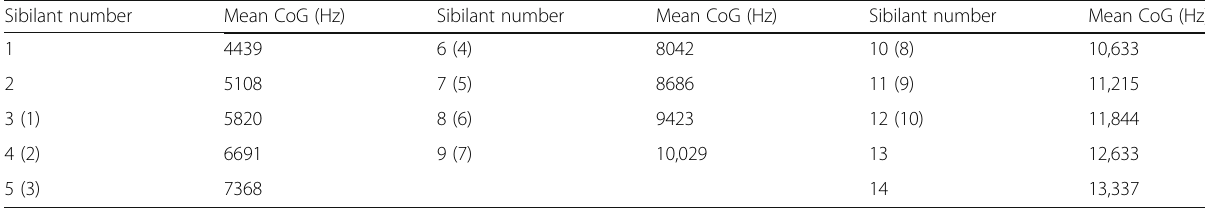
Table 1 Mean center-of-gravity (CoG) values measured in the 14 steps of the naturally produced [ ʃ ]-to-[s] sibilant continuum Sibilant number Mean CoG